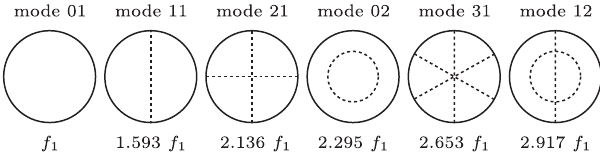
FIG. 15. Graphic representation of the eigenmodes of an oscillating circular membrane with the smallest frequencies; figure adopted according to [7].